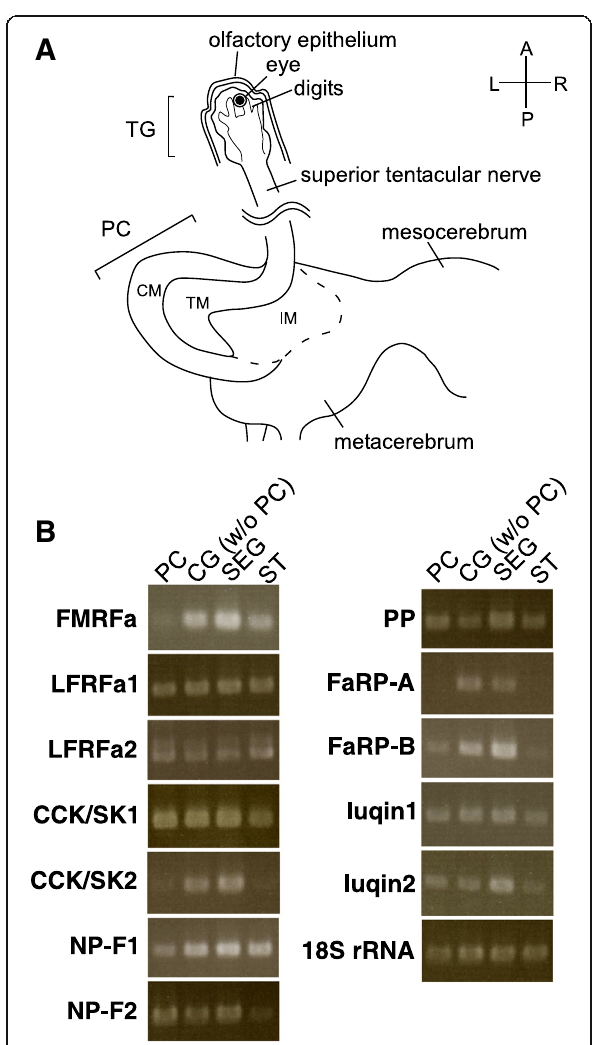
Fig. 2 a A schema of the CG and the ST explaining the structures and the names of the CNS regions pertinent to the present study. Because the IT projects to the TM of the PC from the ventral side, it is not depicted in this figure. TG, tentacular ganglion; PC, procerebrum; CM, cell mass; TM, terminal mass; IM, internal mass. R, right; L, left; A, anterior; P, posterior. b RT-PCR for the 12 RFamide genes using the cDNA templates derived from 4 different parts of the CNS. For the FMRFa gene, the amplicon corresponds to the first exon common to the two splice variants. 18S rRNA serves as an internal control for the template cDNA amount. PC, procerebrum; CG (w/o PC), cerebral ganglia without the PC; SEG, subesophageal ganglia; ST, superior